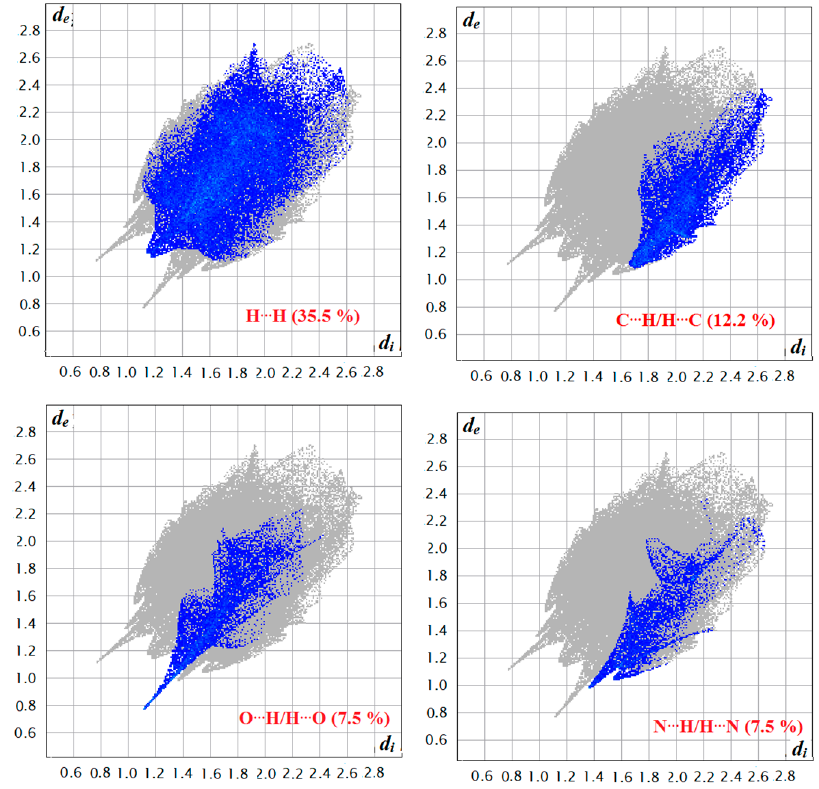
Figure 8. Two dimension finger print plots showing various intermolecular contacts in 287 thesemicarbazones 4 . 288